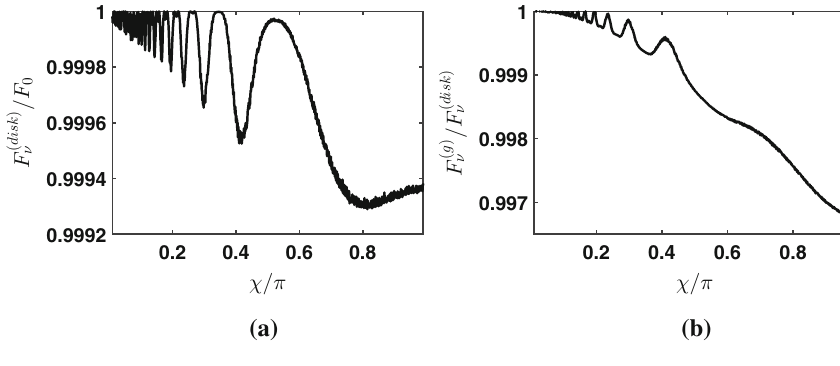
Fig. 4 The ratios of fluxes obtained by the numerical solution of Eqs. (27) and (28) versus χ/π . a The flux of scattered neutrinos, accounting for the matter interaction, F ( disk ) ν normalized by F 0 ; b the ( g ) ( disk ) ratio of F ν and F